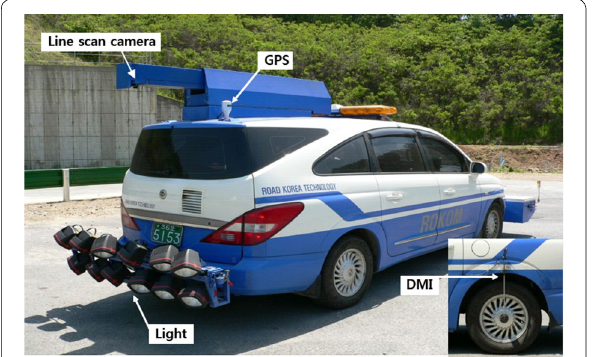
Fig. 3 Photo of the road surface imaging system used for continuous surface image acquisition on the pilot